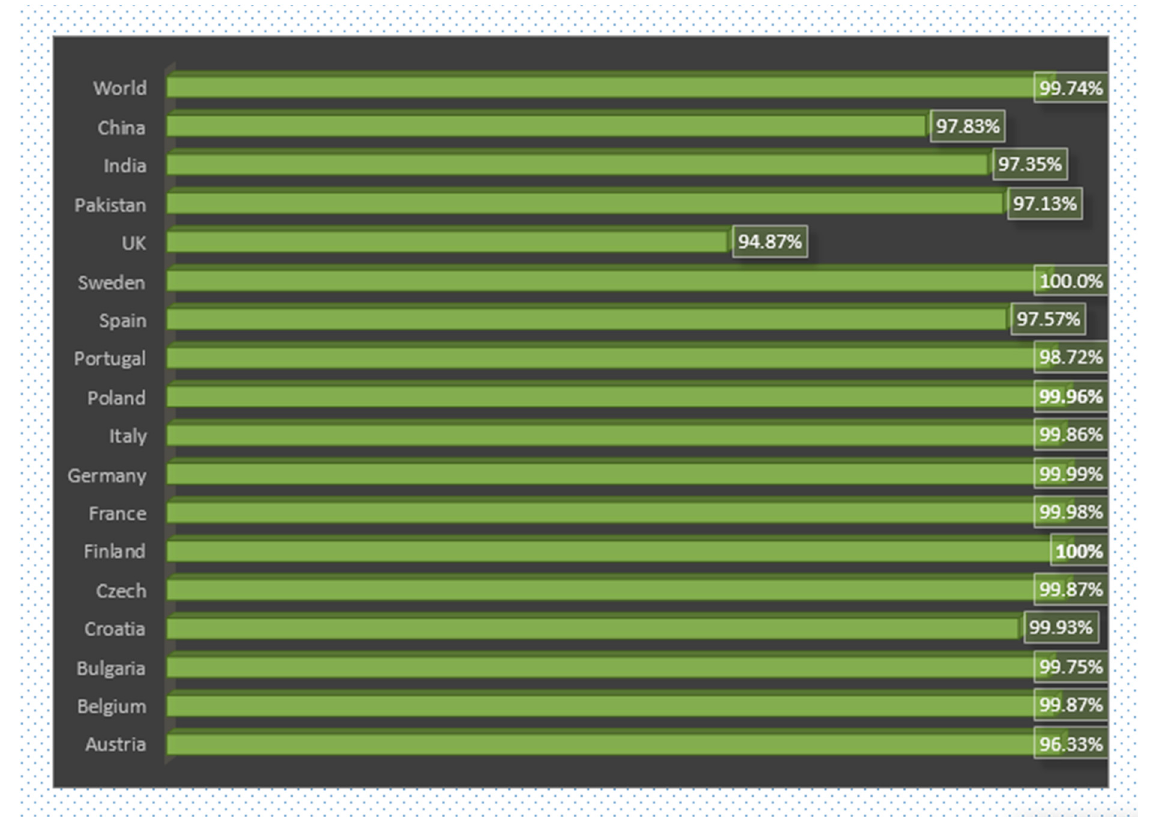
Figure 8. World and different country-wise combined MHC-I and MHC-II coverage of designed vaccine.